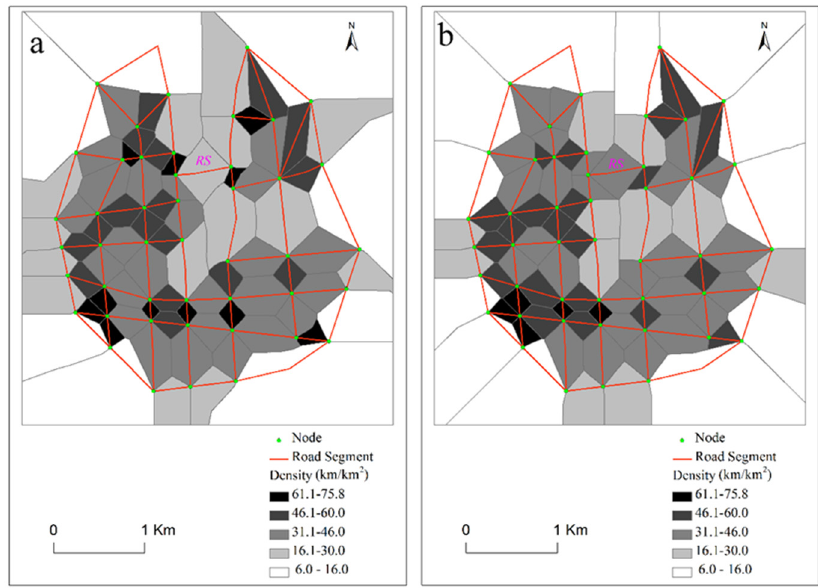
Figure 6. Partition results for the ordinary and weighted Voronoi diagrams: ( a ) weighted Voronoi diagram; ( b ) ordinary Voronoi diagram.